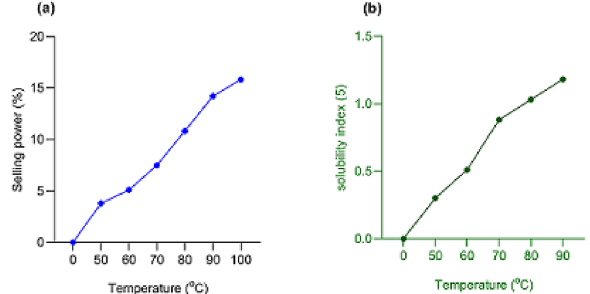
Figure 1. Swelling power and solubility index of ginger starch. Results are means ± SD of triplicate determinations. Charts were drawn using GraphPad prism 8.0 software (GraphPad Software Inc., San